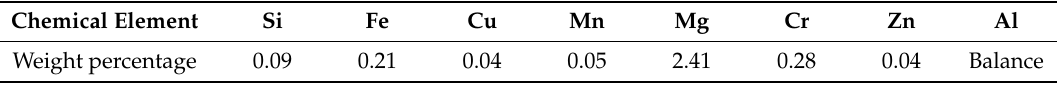
Table 1. Chemical composition of the 5052-O aluminum alloy sheet (wt %). Chemical Element